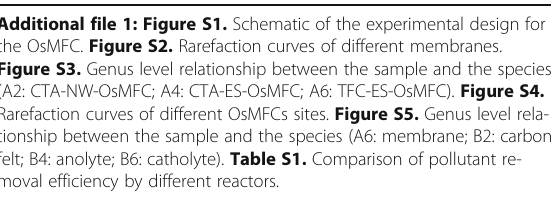
Additional file 1: Figure S1. Schematic of the experimental design for the OsMFC. Figure S2. Rarefaction curves of different membranes. Figure S3. Genus level relationship between the sample and the species (A2: CTA-NW-OsMFC; A4: CTA-ES-OsMFC; A6: TFC-ES-OsMFC). Figure S4. Rarefaction curves of different OsMFCs sites. Figure S5. Genus level rela- tionship between the sample and the species (A6: membrane; B2: carbon felt; B4: anolyte; B6: catholyte). Table S1. Comparison of pollutant re- moval efficiency by different reactors.